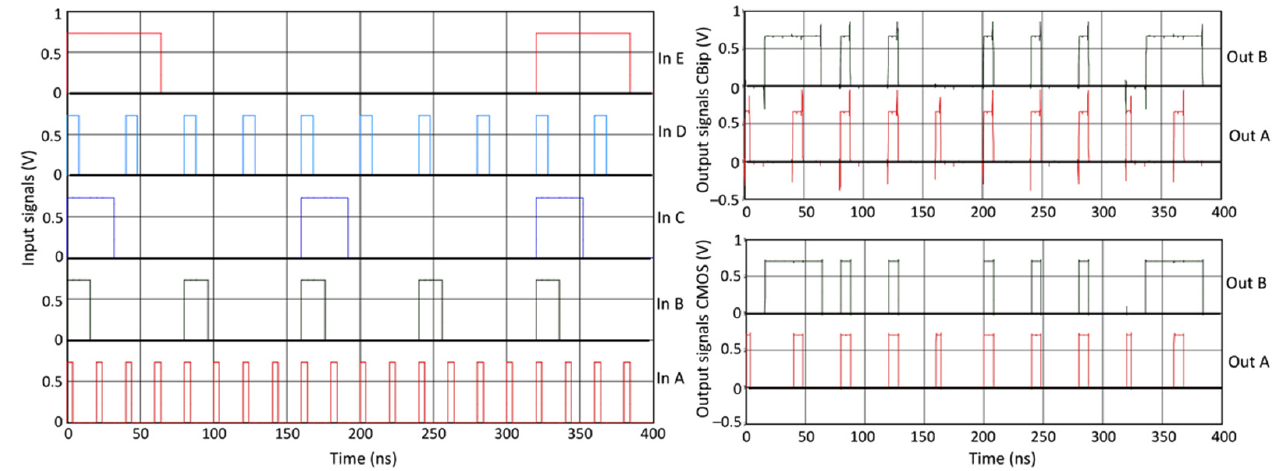
Figure 19. Simulated operation of the ISCAS C17 benchmark: CBip and 22 nm CMOS implementa-